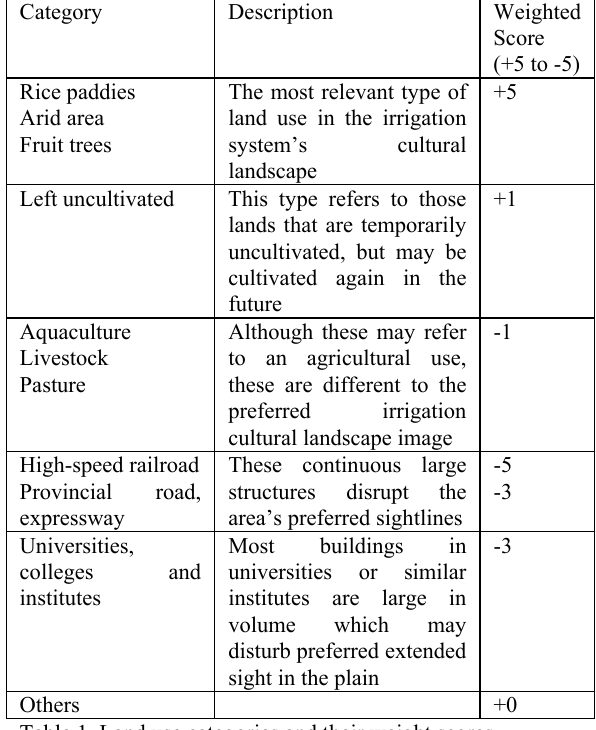
Table 1. Land use categories and their weight scores The Kernel Density Estimation method shows the QGIS and SAGA. The common land use preferred for the irrigation system’s cultural landscape image are marked by different weighted scores for each patch of land. In the KDE, the search radius is set as 300m, while the cell size is set as 100m.